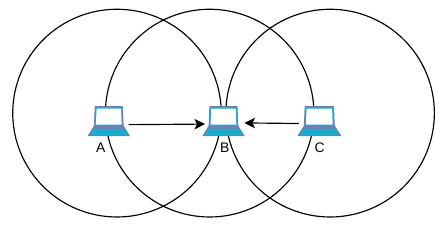
Figure 5. Hidden node